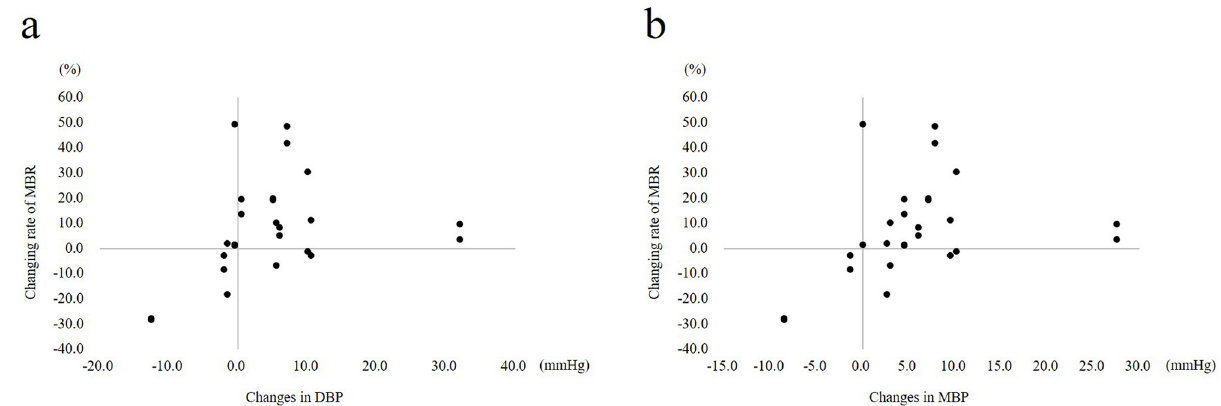
Fig 2. Correlations between the rate of change in macular MBR and mean diastolic blood pressure (DBP) or mean blood pressure (MBP) in the female group. (a) The MBR increase exhibited a positive correlation with the DBP increase in the late follicular phase and mid-luteal phase ( R = 0.456, P = 0.019). (b) There was a statistically significant positive correlation between the MBR increase and the MBP increase in the late follicular phase and mid-luteal phase ( R = 0.474, P =